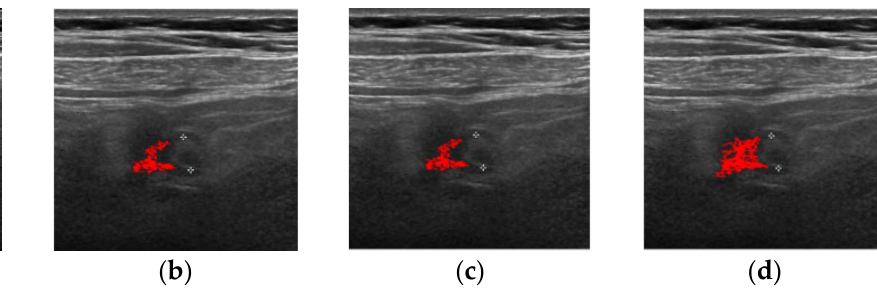
Figure 6. Comparison of DFCM, ORFCM, and DORFCM. ( a ) Input, ( b ) DFCM, ( c ) ORFCM, and